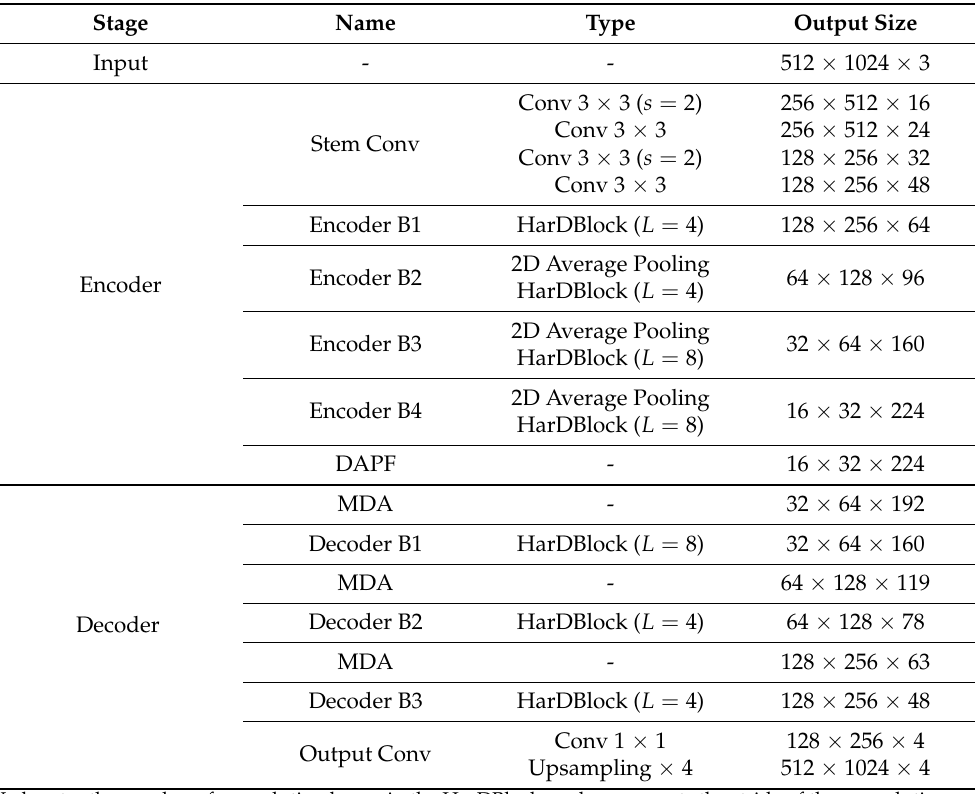
Table 1. Example of the FASSD-Net architecture with a 512 × 1024